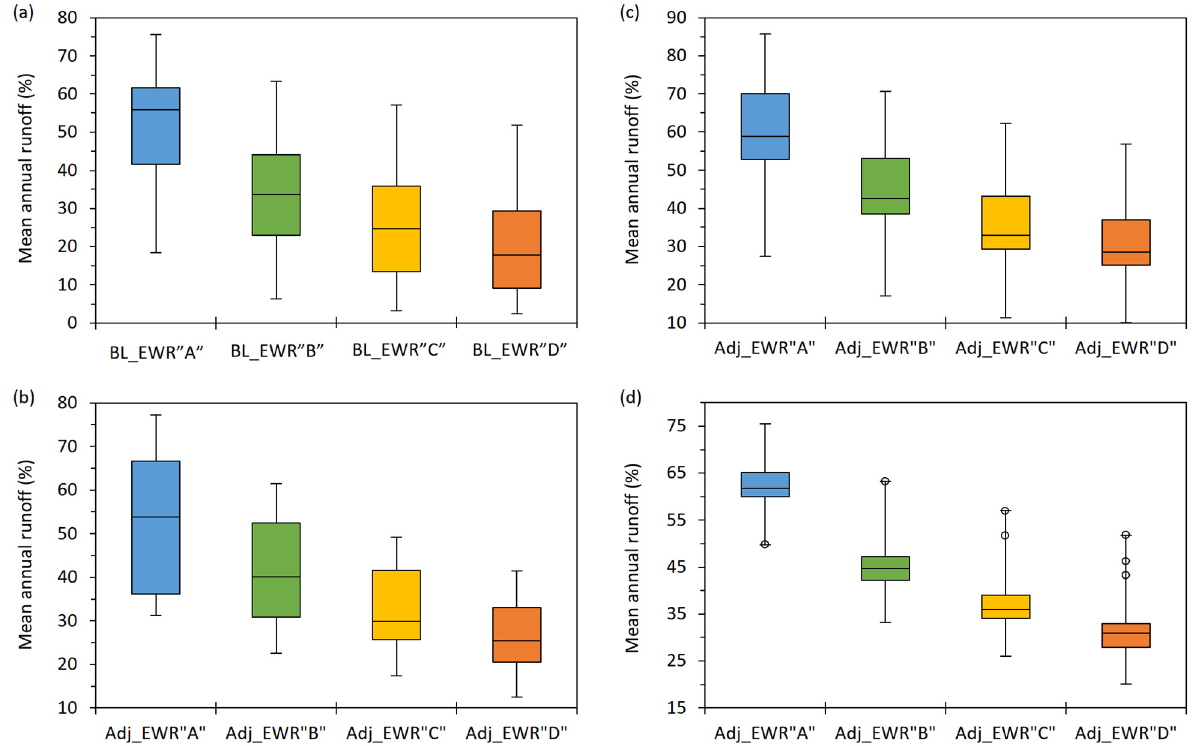
Figure 5. Central and full range of environmental water reserve volumes (EWR in percentage of the mean annual runoff) per environmental objective class (A = blue, B = green, C = yellow, and D = orange). ( a ) The method baseline (BL) criteria applied in the 40 basins, and the adjustments (Adj) based on the new criteria of frequency of occurrence reference values for ( b ) ephemeral ( n = 11), ( c ) intermittent ( n = 12), and ( d ) perennial rivers ( n = 17; outliers displayed in circles).